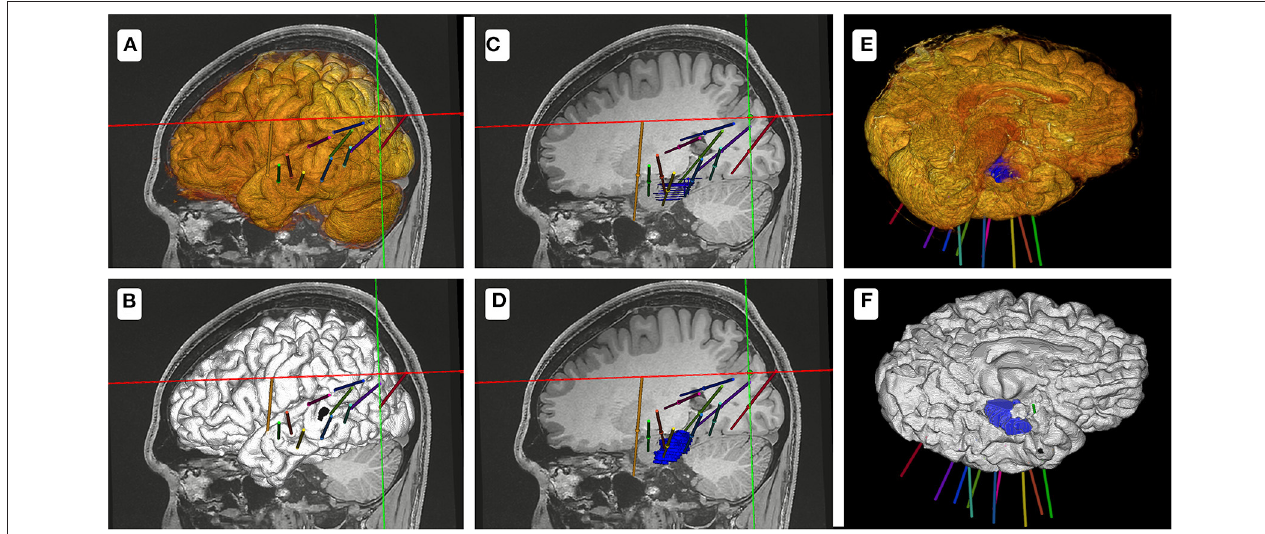
FIGURE 3 | Schematic diagram of the two methods for the electrode-implantation plan. (A,C,E) show the electrode-implantation plan based on the model designed using method 1. (B,D,F) show the electrode-implantation plan based on the model designed using method 2. Because of the high resolution of the model designed using method 2, the design process of the electrode plan is relatively